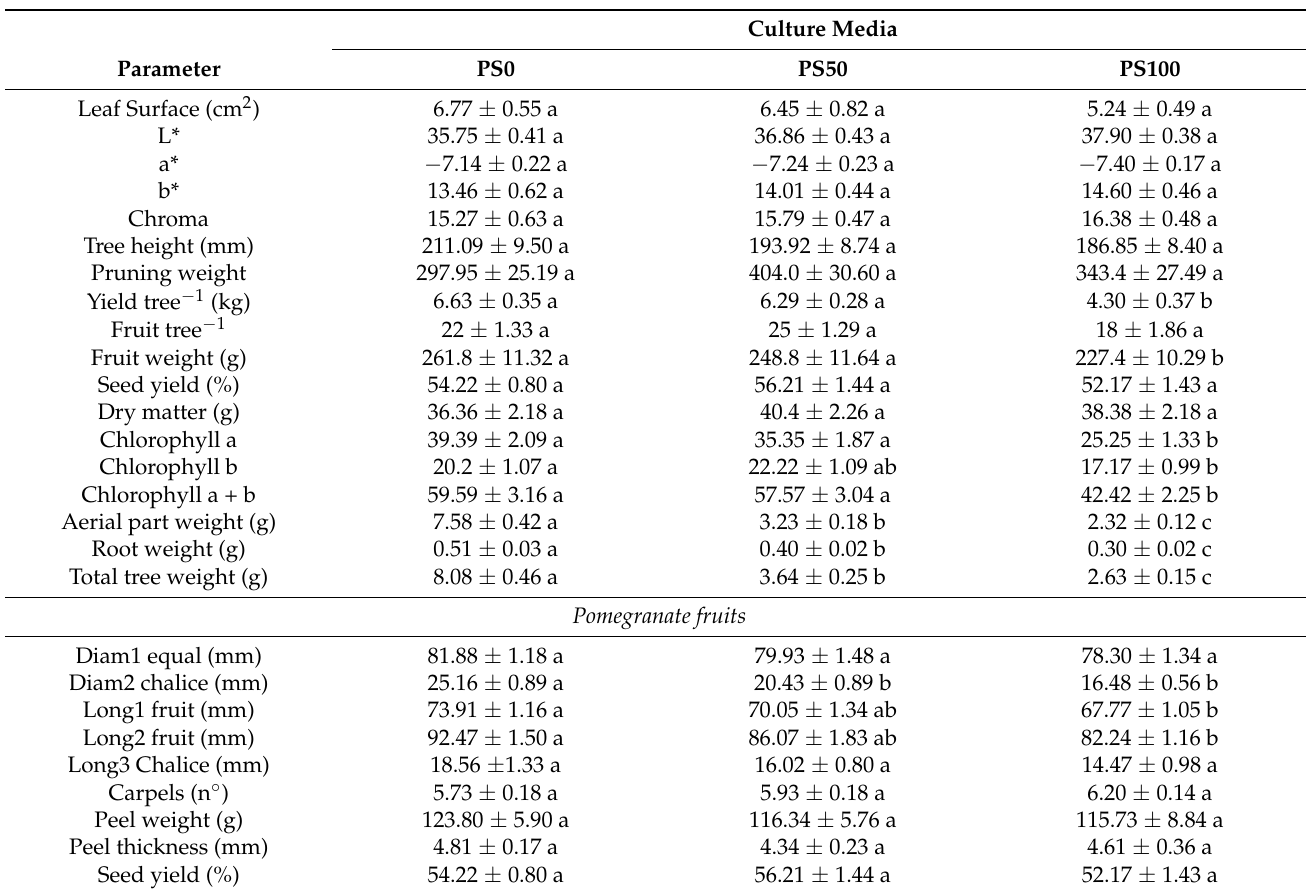
Table 1. Characteristics measured in the pomegranate trees and production obtained for the three substrates tested where PS0 represents the 100% peat; PS50 the mixture of peat and port sediment and PS100 the dredged remediated sediments. The values are the mean ±